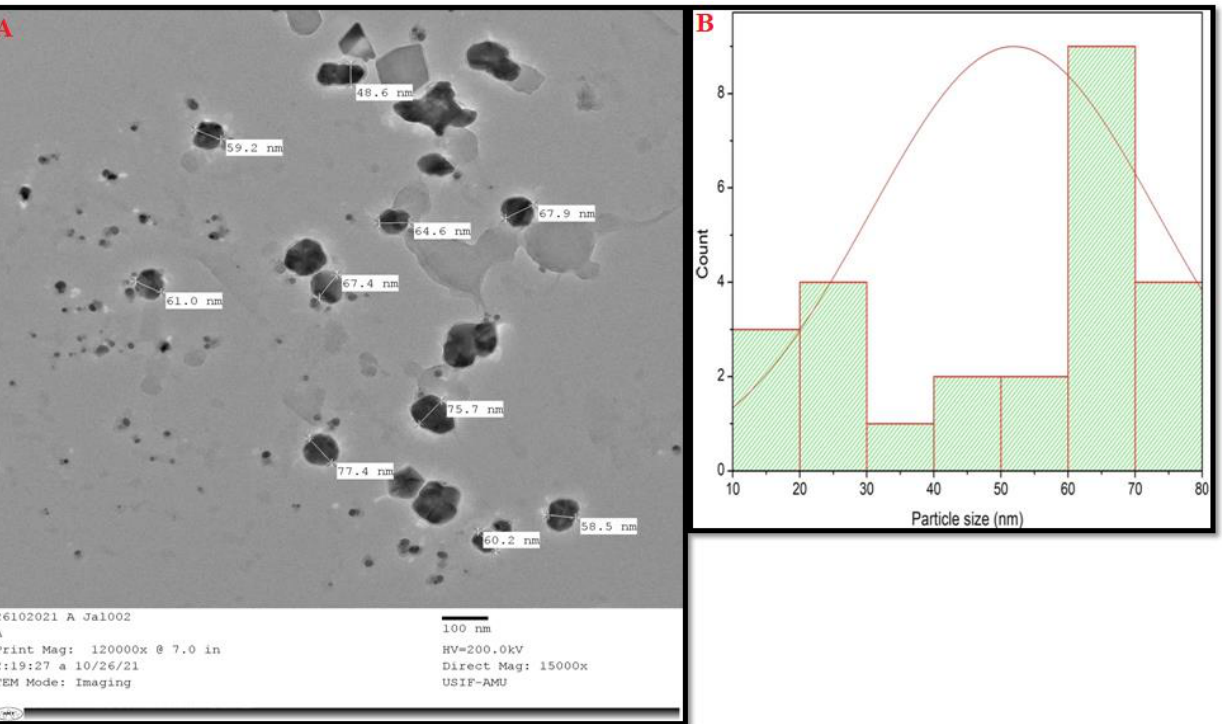
The XRD analysis confirmed the crystalline nature of the nanoparticles. The diffrac- Figure 4. ( A ) Representation of transmission electron microscopy (TEM) of CS-AgNPs. ( B ) Particle Figure 4. ( A ) Representation of transmission electron microscopy (TEM) of CS-AgNPs. ( B ) Particle tion peaks at 38.2°, 44.36, 64.48, and 77.4 related to 111, 200, 220, and 311 facets of the face size distribution of nanoparticles. centered cubic (FCC) crystal lattice, corresponded to silver (JCPDS card no 04-0783) (Fig- size distribution of nanoparticles. ure 5).